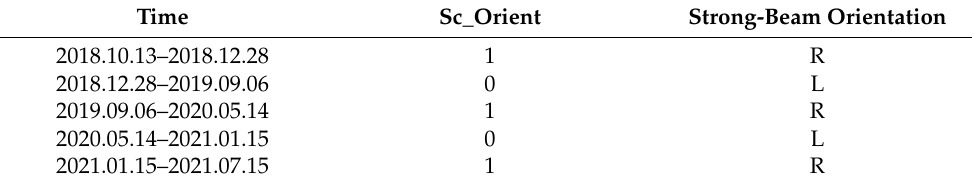
Table 1. The value of sc_orient corresponding to the strong-beam orientation at different times. Time